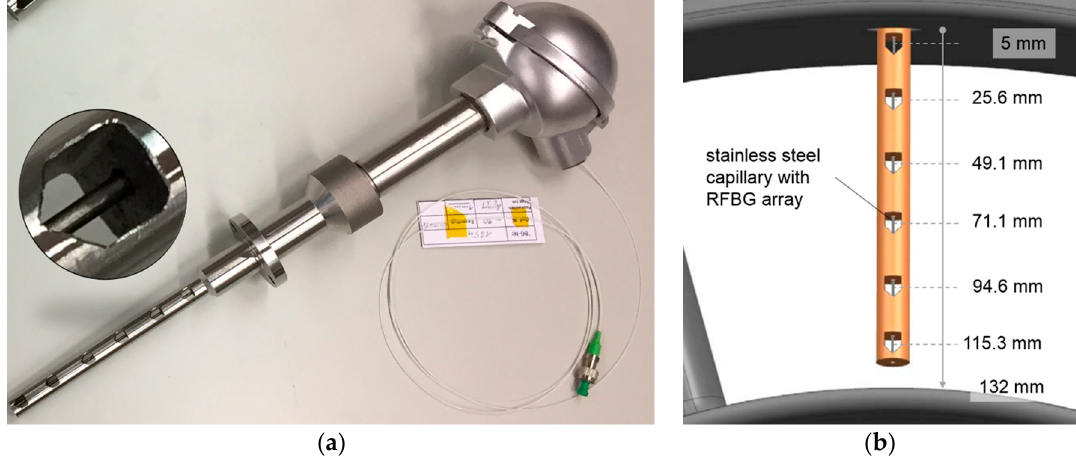
Figure 3. ( a ) Temperature probe with six-point regenerated FBG (RFBG) array. The inset provides an enlarged view of one of the six flow channels of the assembly. ( b ) Installation of the RFBG-sensor probe in the exhaust-gas diffusor of the gas turbine (flow direction perpendicular to plane).